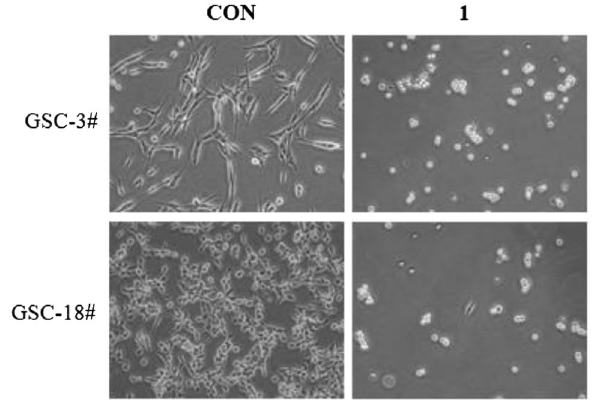
Fig. 4 Compound 1 against human glioma stem cells by phenotypic screening at 20 l